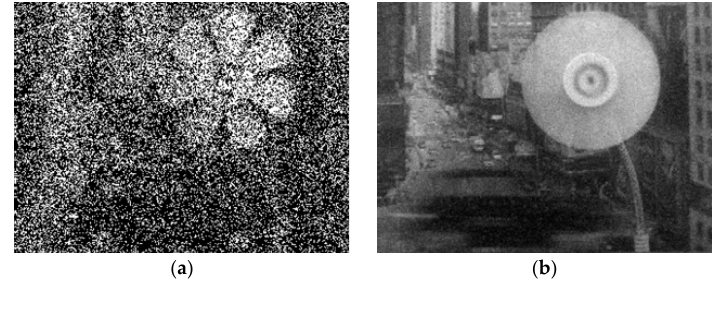
Figure 7. Results for synthetic data with both car and background featuring identical dotted patterns with photon rates H 1 = 0.35 (in dot) and H 2 = 0.05 (elsewhere). ( a ) Bit-plane at time i = 1; ( b ) Bit-plane at time i = 36; ( c ) Reconstructed vehicle (shown over a region of interest of 230 × 90). The quality of the reconstruction is R =